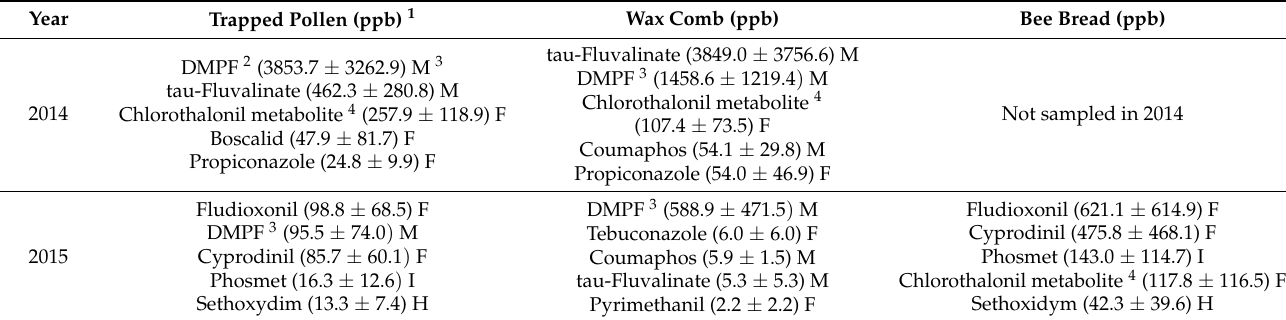
Table 1. Pesticide residues in highest average concentrations (ppb/location) in trapped pollen, wax comb, and bee bread, in 2014 and 2015.